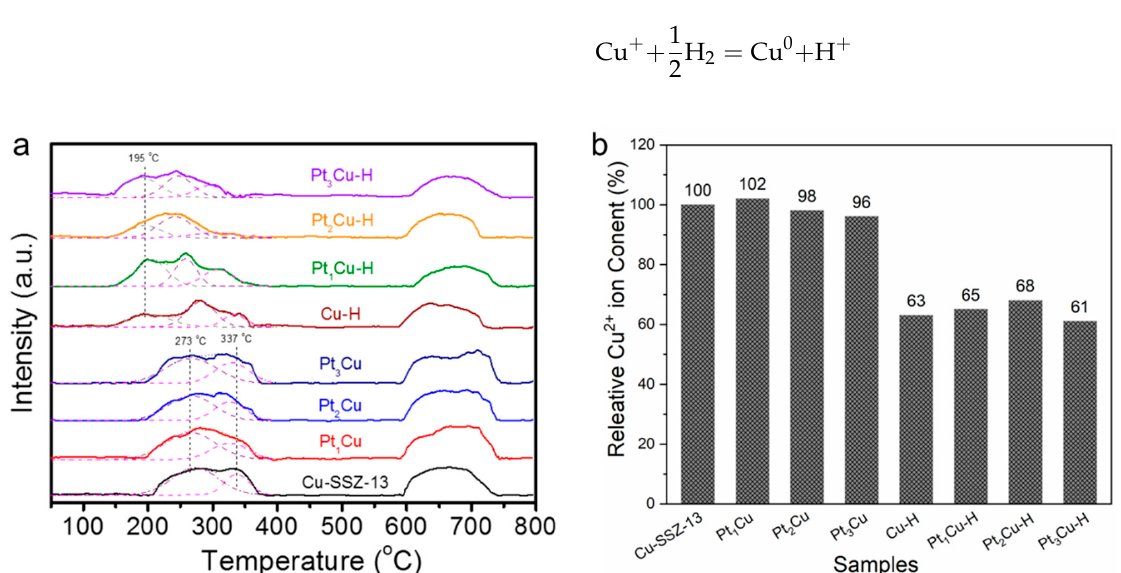
Figure 4. ( a ) H 2 -TPR spectra of fresh and aged Cu-SSZ-13 and PtxCu samples; ( b ) the relative Cu 2+ ion content in the catalyst samples, using Cu-SSZ-13 as a reference.